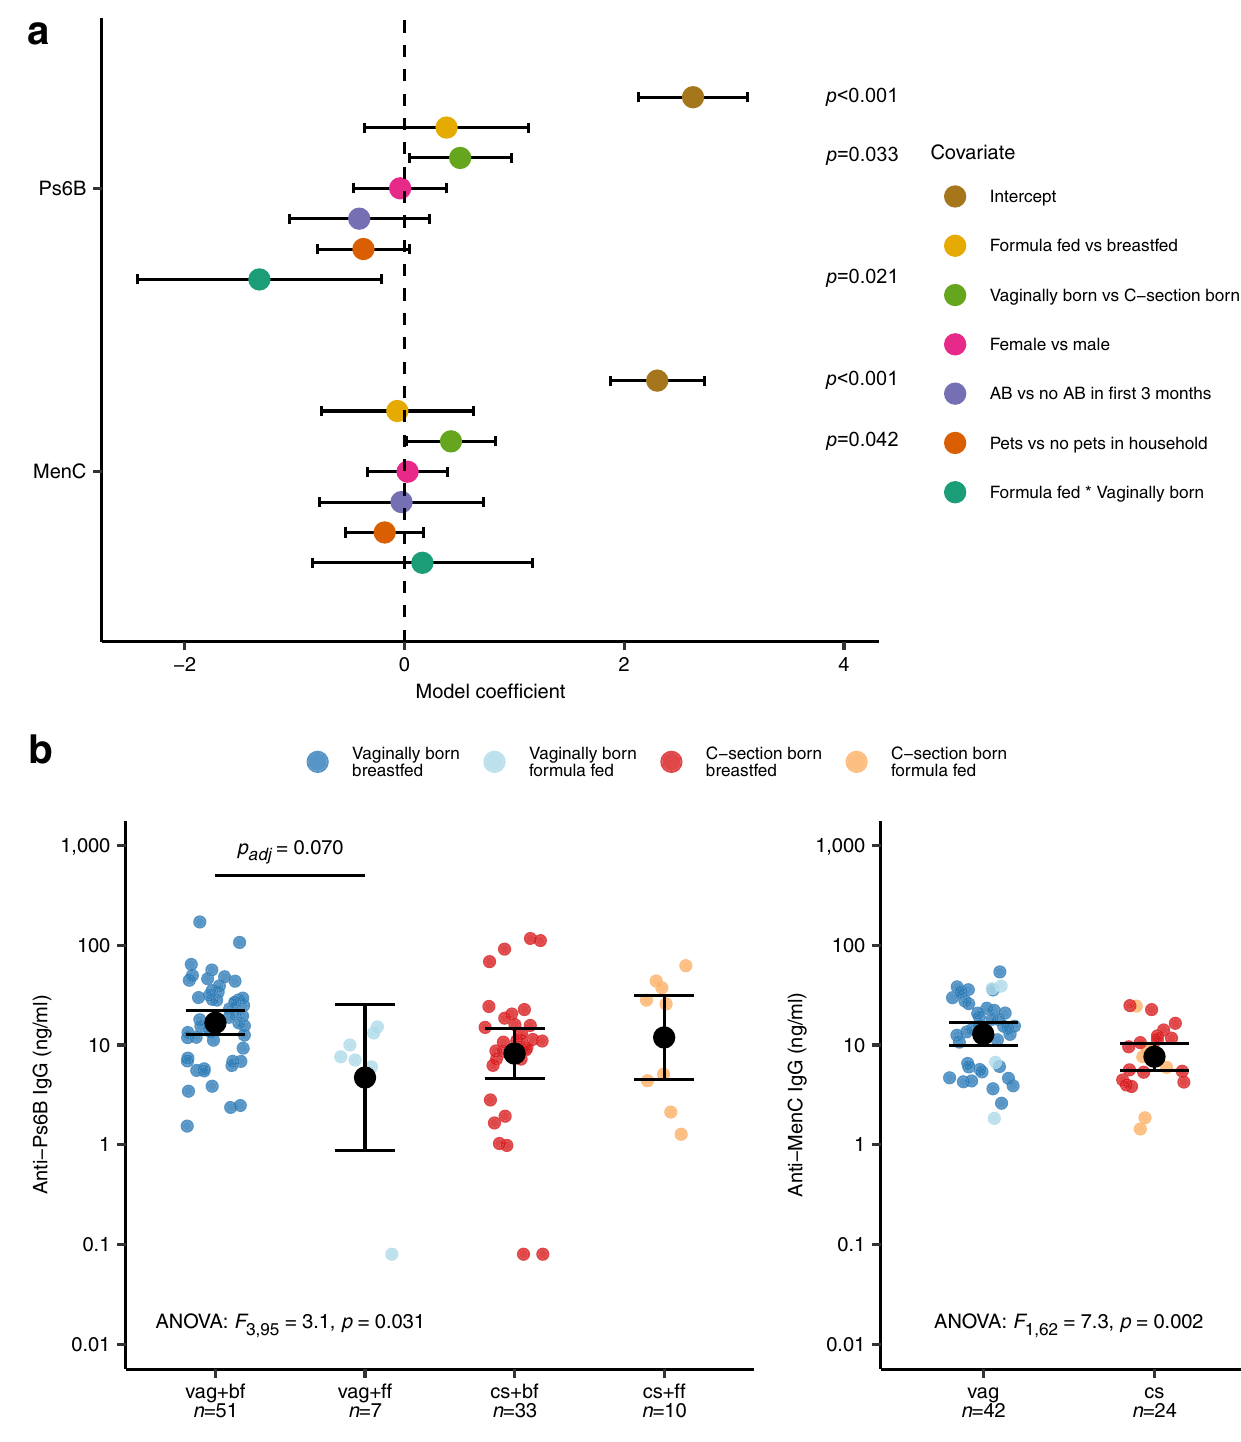
Fig. 2 | Associations between early life exposures and anti-pneumococcal and anti-MenC IgG concentrations following vaccination. a Data are presented as model coef fi cients with 95% CI per covariate computed with two-sided multi- variable linear regression with log-transformed anti-Ps6B ( n =101) or anti-MenC ( n =66) IgG concentrations as dependent variable. The analysis was not adjusted for multiple comparisons. C-section=cesarean section; AB=antibiotics. b anti- pneumococcalserotype6B (anti-Ps6B)IgG responses forvaginally born, breastfed (vag+bf, n =51), vaginally born, formula fed (vag+ff, n =7), C-section born,